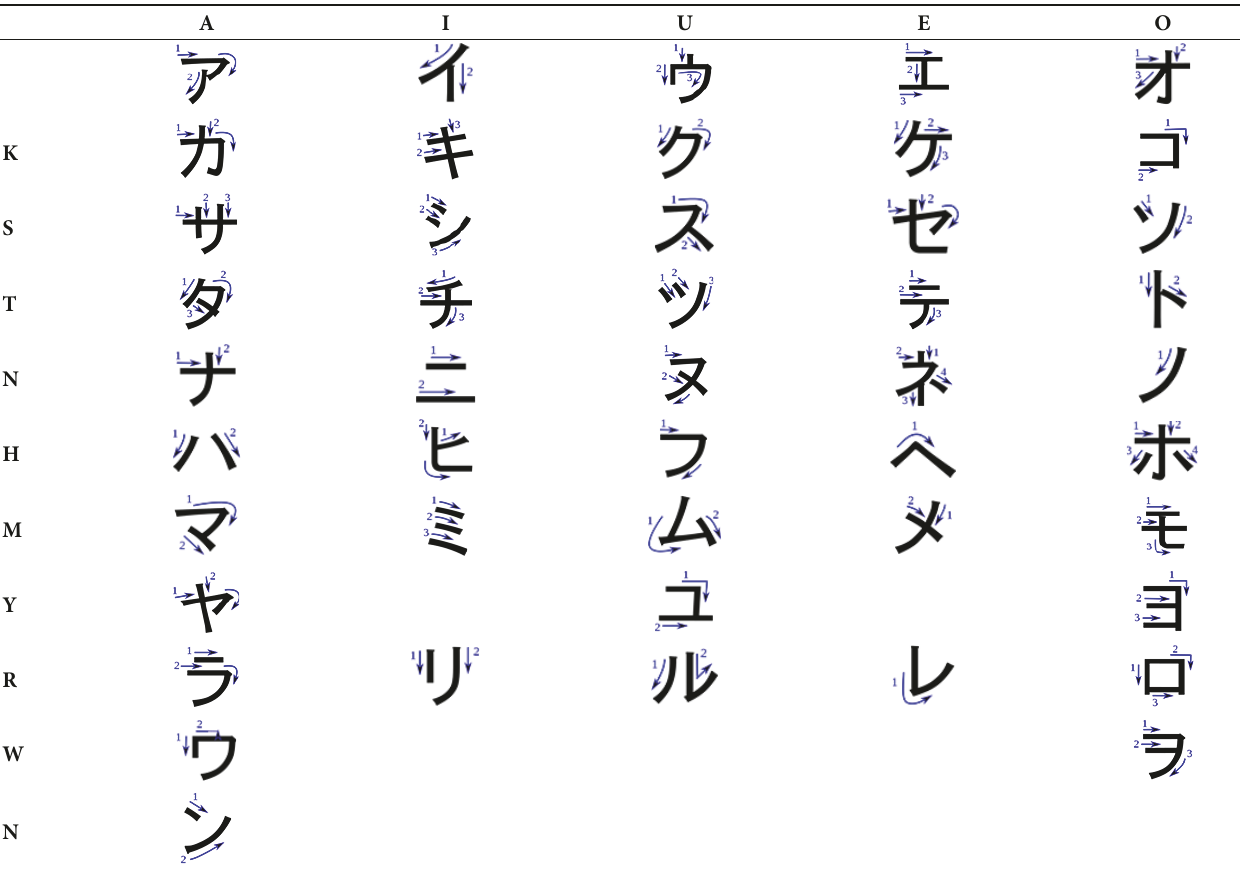
Table 4: Katakana Letter.